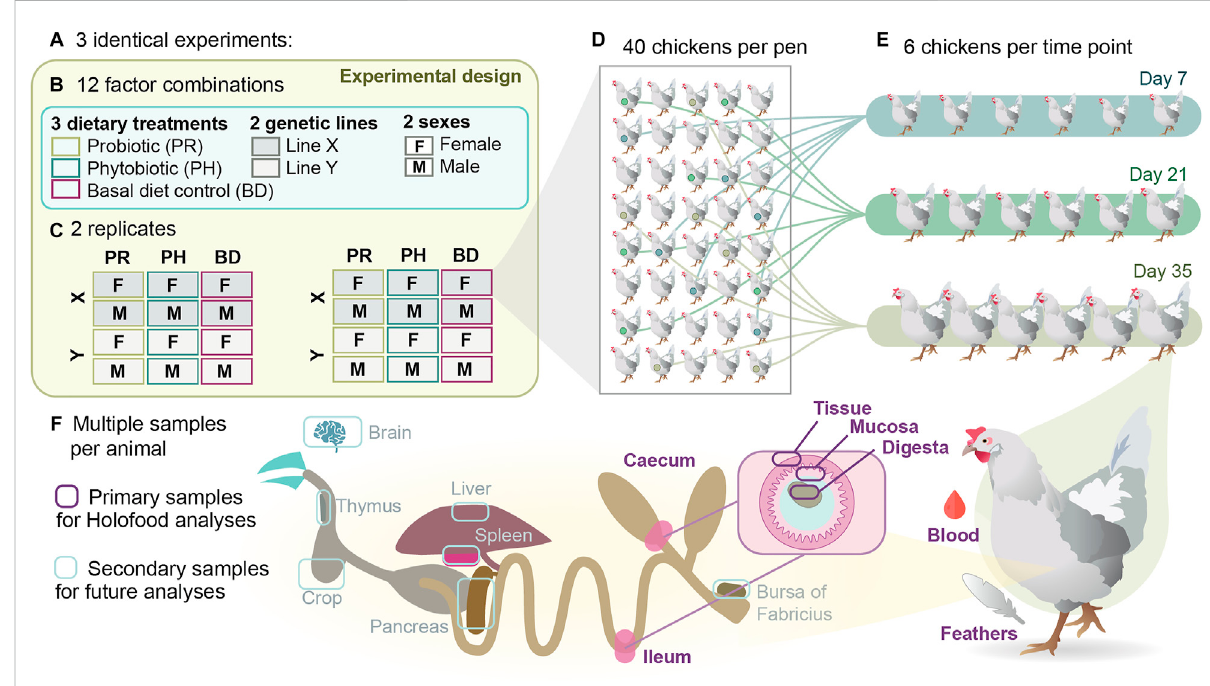
FIGURE 1 Experimental, sampling and analytical design of the HoloFood study focused on broiler chickens. (A) Three experiments with identical study designwereconducted in2019. (B) Eachexperimentcontained12 factor combinations ofthreedietarytreatments,twogenetic lines andtwo sexes. (C) Eachcombinationwasreplicatedtwiceperexperiment,yielding24pensperexperimentand72pensintotal. (D) Eachpencontained40chickens in the beginning of the experiment, 18 experimental animals that were randomly selected and tagged the fi rst day of the experiment, and 22 more animals that provided commercial-like density conditions. (E) Six chickens were euthanised at day 7, six more at day 21 and six more at day 35 for collecting samples for performance, multi-omic and complementary analyses. (F) From each animal, 14 tissue and digesta samples were collected for a variety of analyses (see Table 1 for details), and complementary organ samples were also collected for future